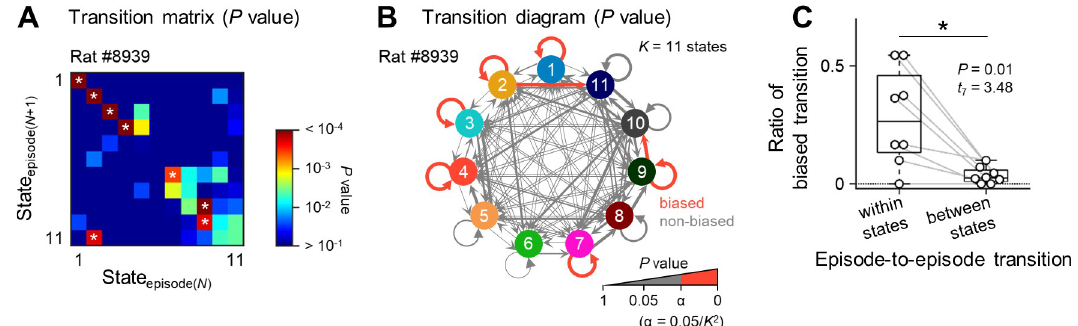
Fig 3. Dynamics of transition patterns of neural activity. A , Transition from the N th episode ( i . e ., episode( N )) to the next was transformed into a state-to-state transition matrix, where a state to which the episode( N ) belonged was represented as a state episode( N ) . Warmer colors indicate that a given state-to-state transition was significant. Note that white asterisks in the heat map indicate P < 0.05/121 and that these transitions were named biased transitions. B , The transition matrix (shown in A ) was transformed into a transition diagram. Red and gray arrows indicate biased and nonbiased state-to-state transitions, respectively. Thicker arrows represent lower P values. C , The ratio of biased transitions to all transitions within the identical states was significantly higher than that between distinct states.